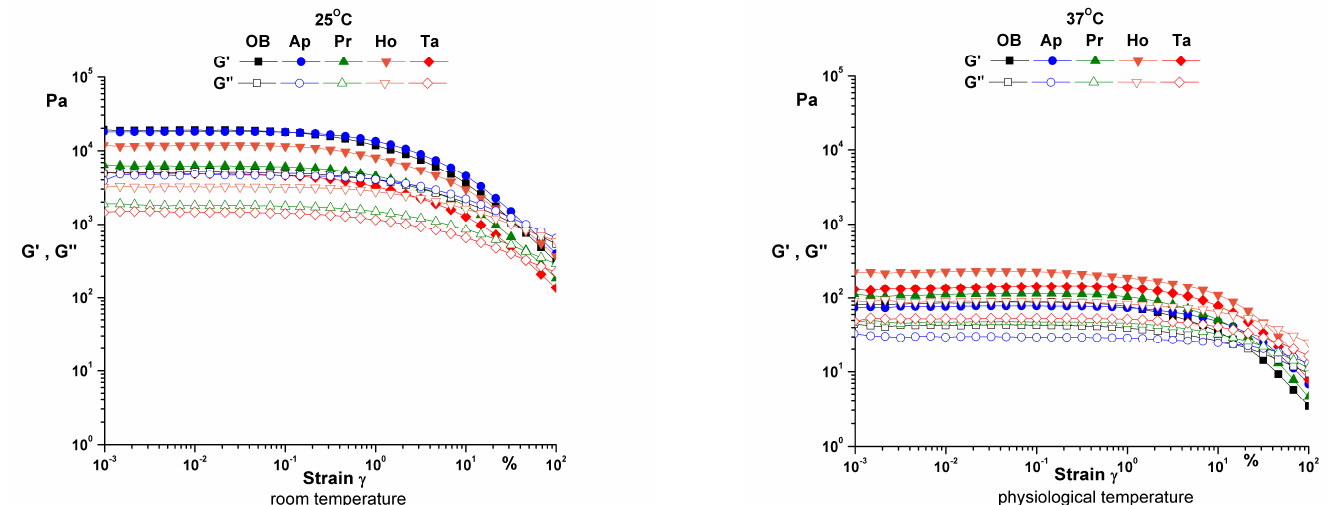
Figure 2. Amplitude sweep for analyzed ointments at both temperatures (25 and 37 ◦ C). OB—ointment base, Ap—ointment base + apilarnil, Pr—ointment base + propolis, Ho—ointment base + honey, Ta—ointment base + mixture of bee products.